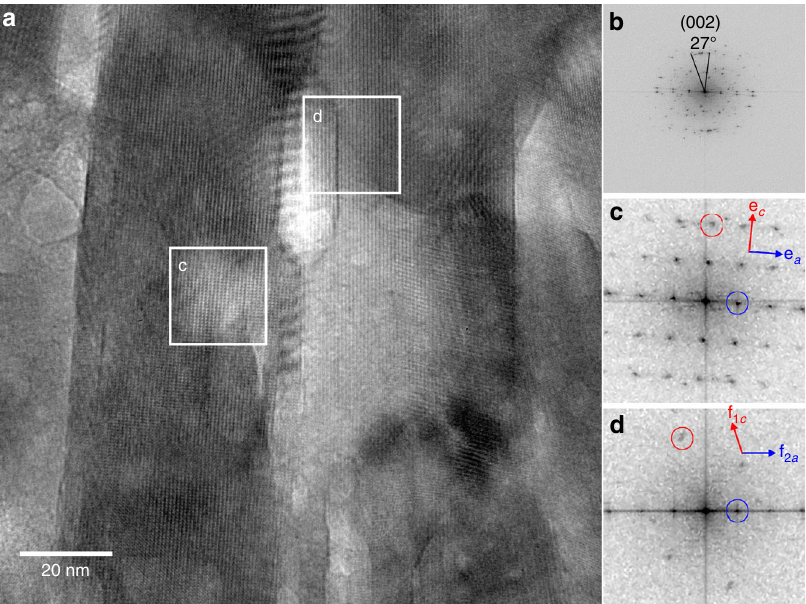
Fig. 4 Crystal orientations of a thin section within a human outer enamel rod showing c -axis misorientation by 23°, 27°, and >18°. a HR-TEM micrograph taken from a 130 nm × 130 nm × 100 nm volume within an outer enamel rod, with crystals elongated in plane from top to bottom in ( a ) (termed vertical hereafter). b Fast Fourier transform (FFT) analysis of the entire image in ( a ), showing that two of the crystals within this entire volume have their c -axes mis-oriented by 27°. e , f FFT power spectra extracted from ( c ) and ( d ) in ( a ), which include crystals with their (100) planes almost parallel and vertical. In e and f red circles and arrows identify (002) spacings and c- axis directions, respectively; blue circles and blue arrows identify (100) spacings and directions of a- axes, respectively. The ( e ) FFT indicates the presence of a single crystal of carbonated apatite with its c -axis oriented 5° clockwise from the vertical and its a -axis at 90° from the c -axis as expected for apatite. The ( f ) FFT indicates the presence of two overlapping crystals, f 1 and f 2 . The a -axis of crystal f 1 is horizontal (blue circle). No (001) lattice fringes were detected for f 1 , thus its c -axis is out of the image plane in ( a ). The c -axis of crystal f 2 is oriented at 18° counterclockwise from the vertical (red circle). No (100) lattice fringes were detected for f 2 , thus its a -axis is out of the image plane in ( a ). Crystal f 2 is oriented with its c -axis 18° counterclockwise from the vertical, thus the angle between the c -axes of crystals f 1 and f 2 is at least 18°, but it could be as large as 90°. The c -axes of crystals e and f 2 are 18° + 5° = 23° apart. Since enamel crystals are on average 26 nm × 63 nm in cross-section 18 , the 30-nm wide crystals at the center of the image in ( a ) must be oriented nearly edge-on. Since this section is 100 nm thick, all three crystals identi fi ed in the FFTs are either in close proximity to or directly abutting one another. Thus, the c -axes of crystals in close proximity are 23°, 27° and somewhere between 18° and 90° apart. Supplementary Fig. 5 shows where the tooth sample was FIBed to extract this thin